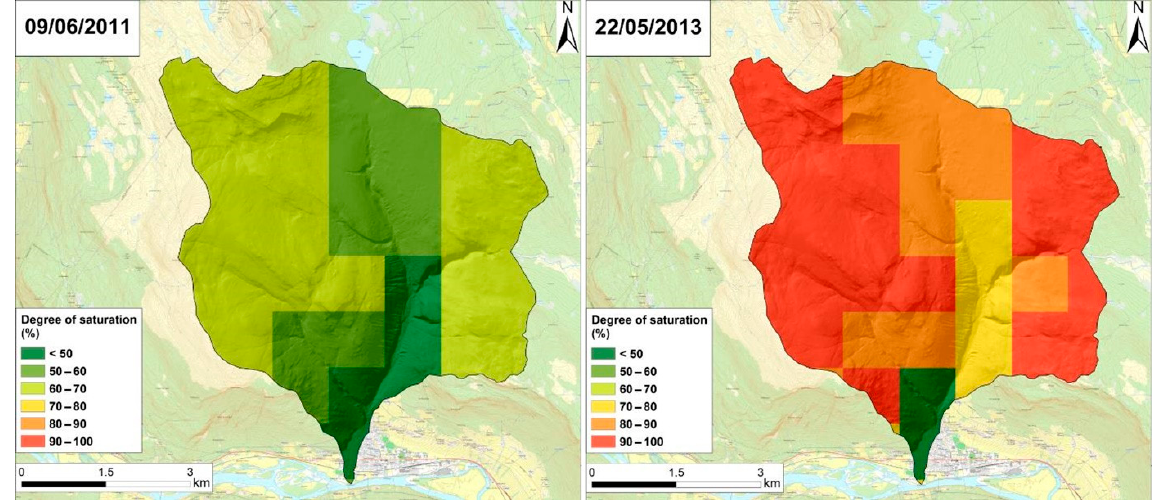
Figure 7. Estimated degree of soil saturation on 9 June 2011 ( left ) and on 22 May 2013 ( right ) at 6:00 a.m., according to the distributed version of HBV model.